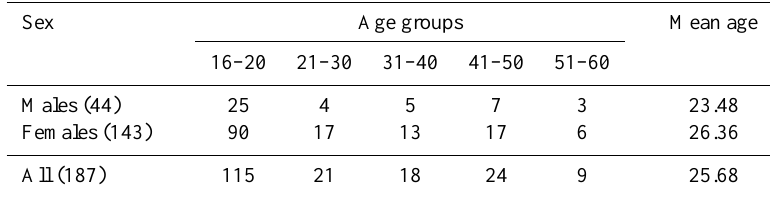
Table 1. Distribution of the investigated persons by sex and age